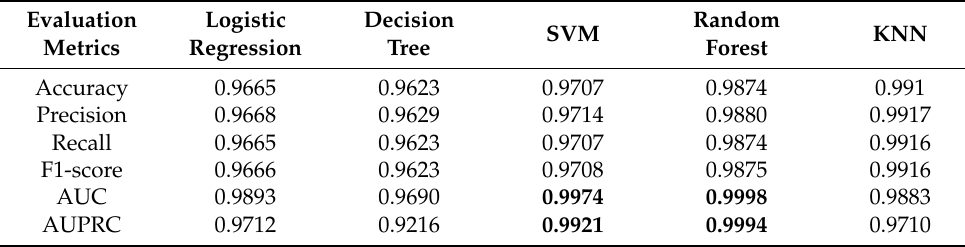
Table 5. Predictive performance of different classification